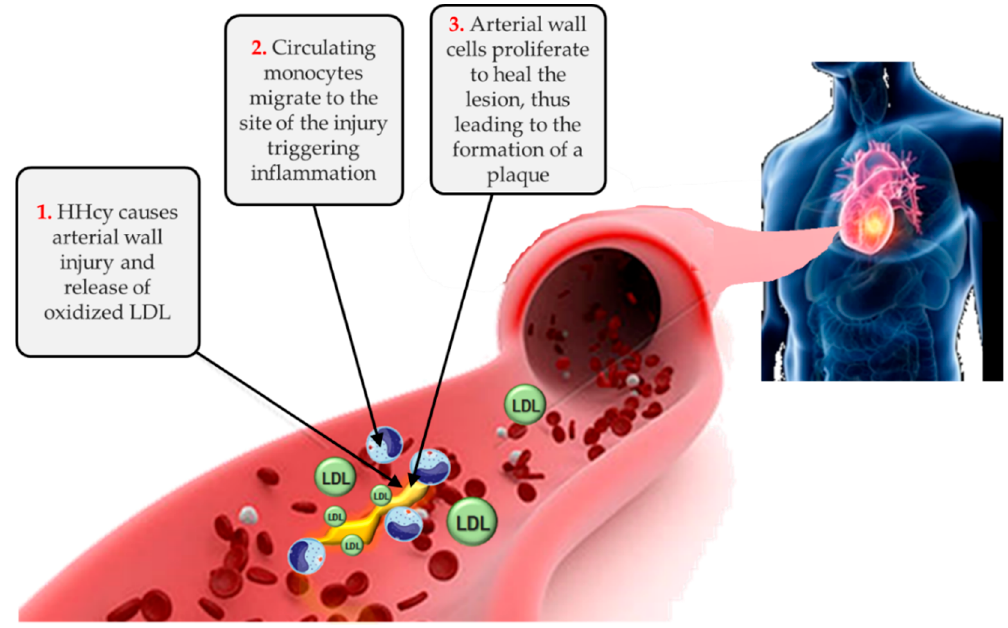
Figure 1. Hyperhomocysteinemia in the atherosclerotic process. HHcy, hyperhomocysteinemia, LDL, low density lipoproteins.